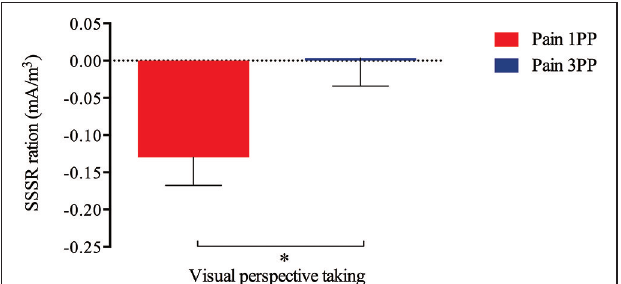
FIGURE 2 | A significant difference ( t (16) = –2.89, p = .005, α = .006) was detected according to visual perspective after the painful outcome onset (i.e., while third picture presentation; 1900 to 2100 ms) . More specifically, painful stimuli seen in 1PP produced a higher SSSR decrease ( M = –.13, SD = .15) than those observed in 3PP ( M = .003, SD =